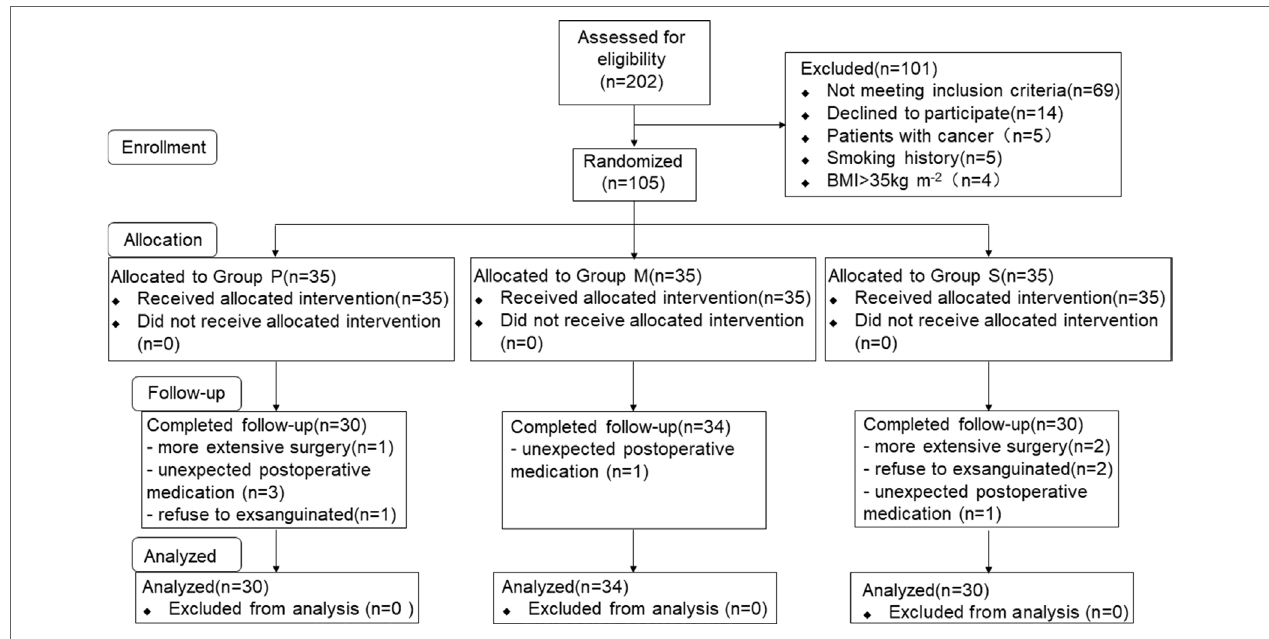
FIGURE 1 | Study flow diagram. BMI, body mass index.